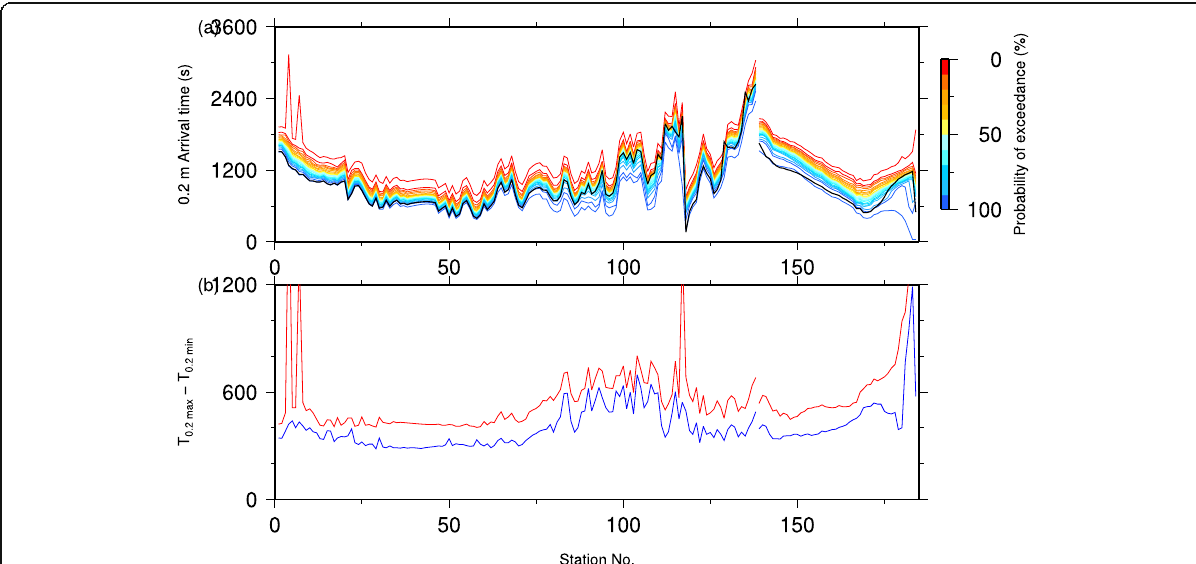
Fig. 7 Statistical characteristics of tsunami arrival times. The arrival time is defined as the time of arrival of the first tsunami for which the wave height exceeded 0.2 m above sea level. a Conditional probabilities of exceedance of arrival times. The black line is for arrival times computed for a uniform slip distribution. b Difference between the latest and earliest arrivals at each site (red line). The blue line is computed for the